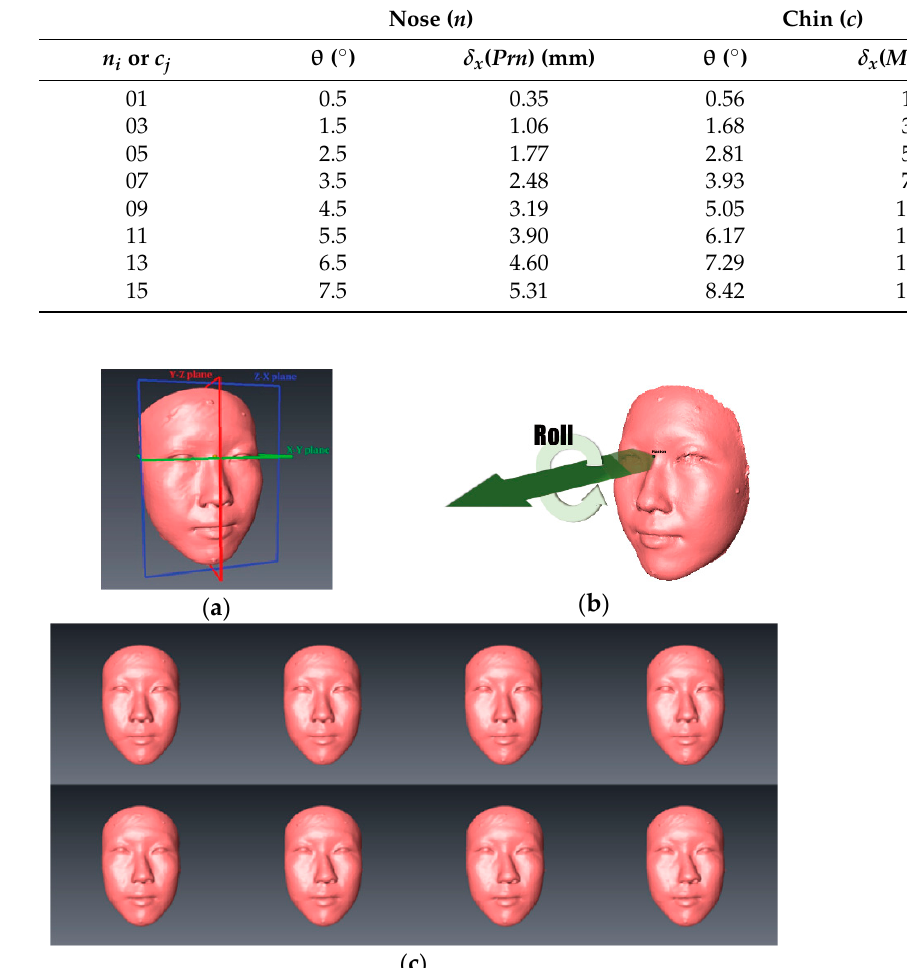
Figure 2. Procedure of composing the facial asymmetry quadruple. ( a ) Facial coordinates; ( b ) Counter-clockwise roll around the Z -axis with Nasion (N) as the origin; ( c ) Deformed